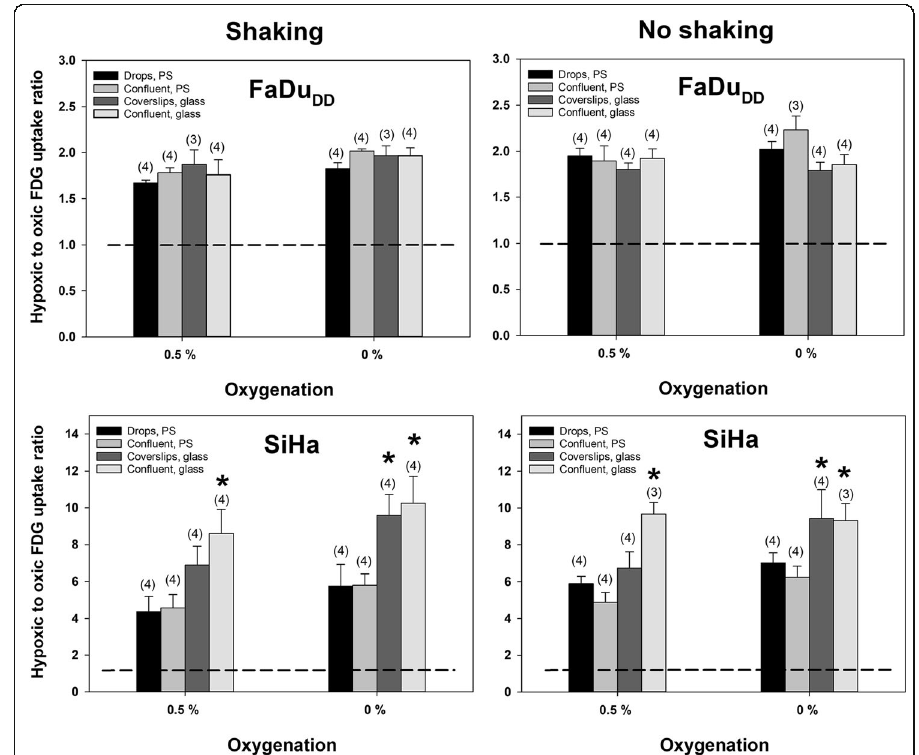
Fig. 2 Oxygenation-dependent [ 18 F] FDG uptake and its dependency on plating material, shaking conditions and cell number (growth area). [ 18 F] FDG retention under hypoxic (0.5% O 2 ) and anoxic (0% O 2 ) gas equilibration is expressed relative to the radioactivity measured in well-oxygenated (21% O 2 ) cells. Values are means (± SEM). The number of independent experiments for each condition is given in parentheses. The asterisks denotes a significant difference between glass and polystyrene at a given oxygenation, cell number (growth area) and shaking condition ( p <